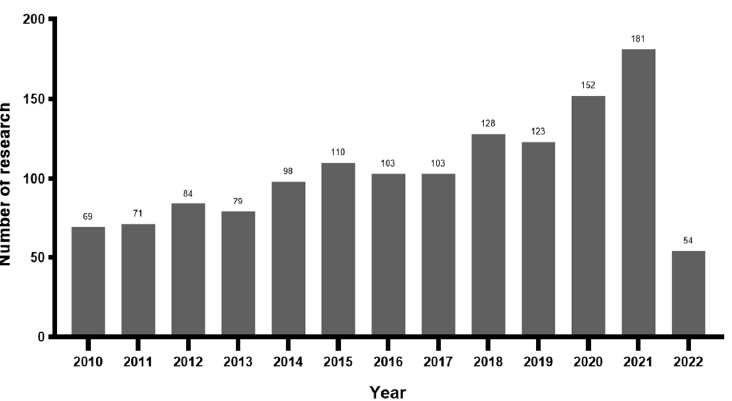
Figure 2. Distribution of publications by year in research on physical activity during pregnancy.